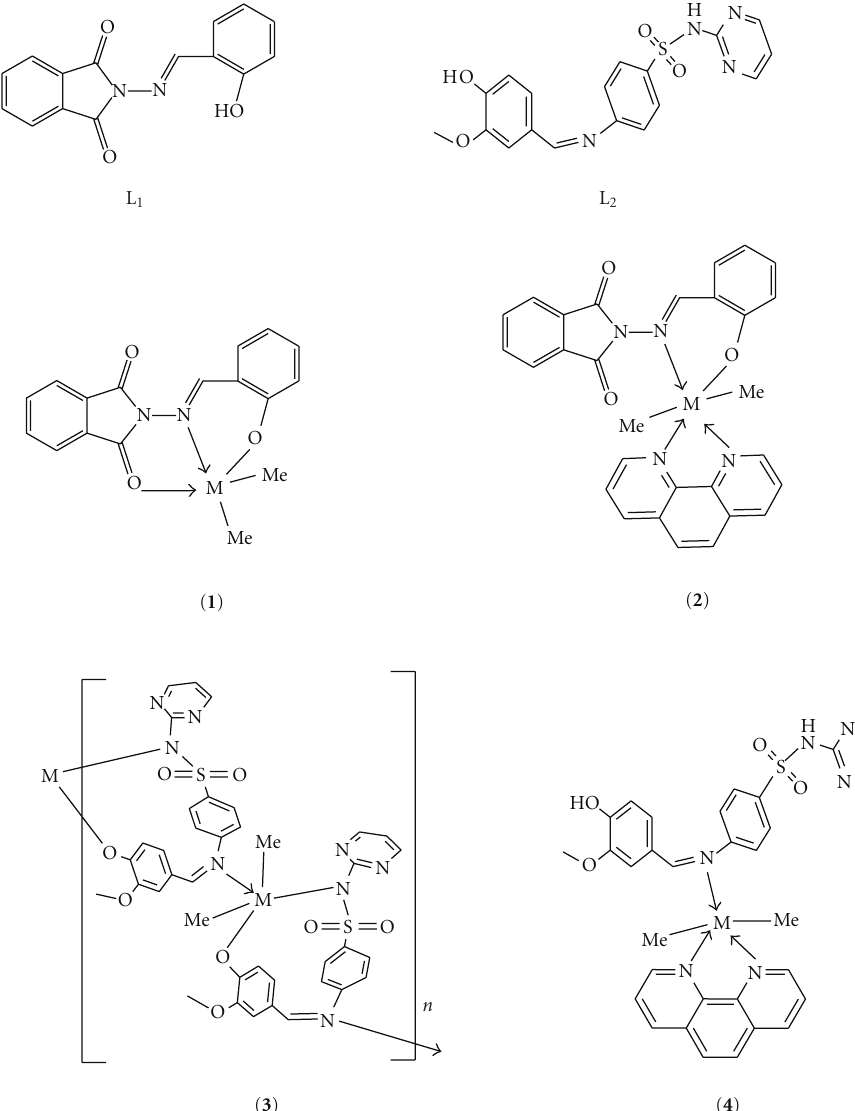
Figure 2: Structures of ligands and organotin(IV) complexes [M = Sn(IV)].